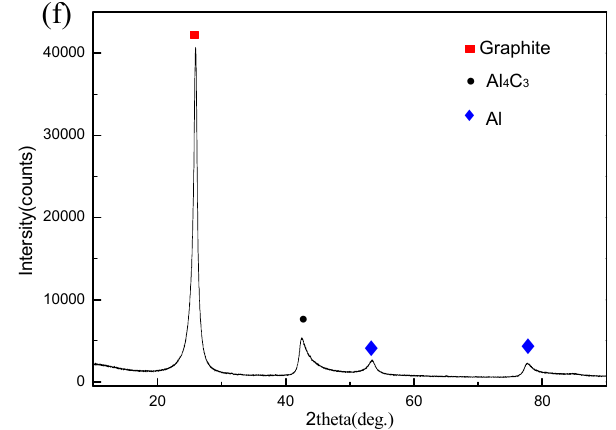
Figure 10. SEM and XRD of C/C–Al–Mg. ( a ) Initial conditions; ( b ) The early infiltration process; ( c ) The middle of the infiltration process; ( d ) The end of the infiltration process; ( e , f ) energy dispersive spectroscopy (EDS) and XRD.